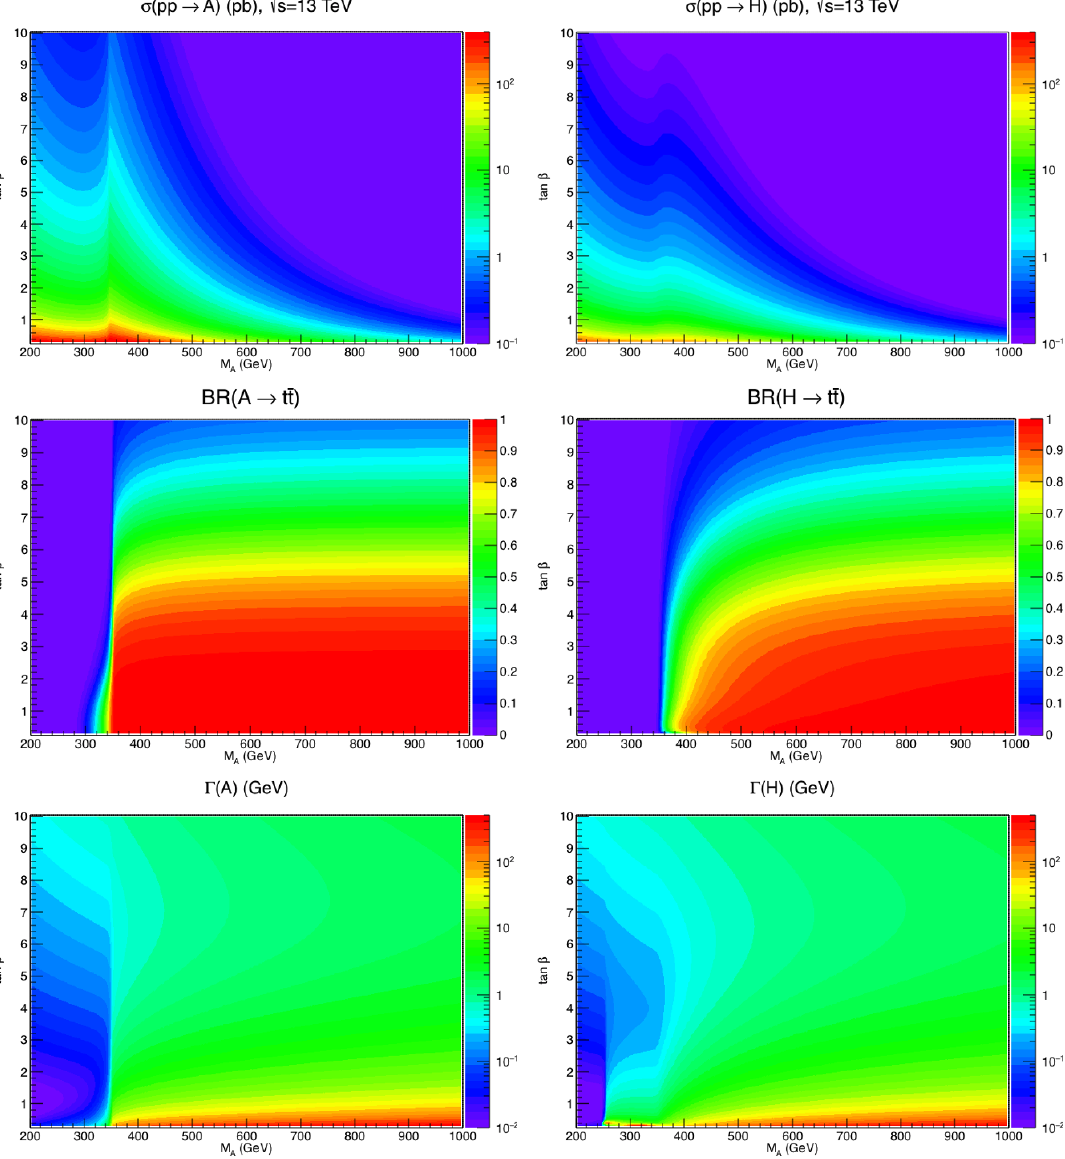
Figure 6 . The gg ! (cid:8) production cross sections at the 13 TeV LHC, the (cid:8) ! t (cid:22) t branching ratios and the total decay widths (cid:0) (cid:8) of the 2HDM CP-odd A boson (left) and heavy CP-even H boson (right) in the [ M A ; tan (cid:12) ] plane, assuming a (cid:12)xed mass splitting M H = M A .